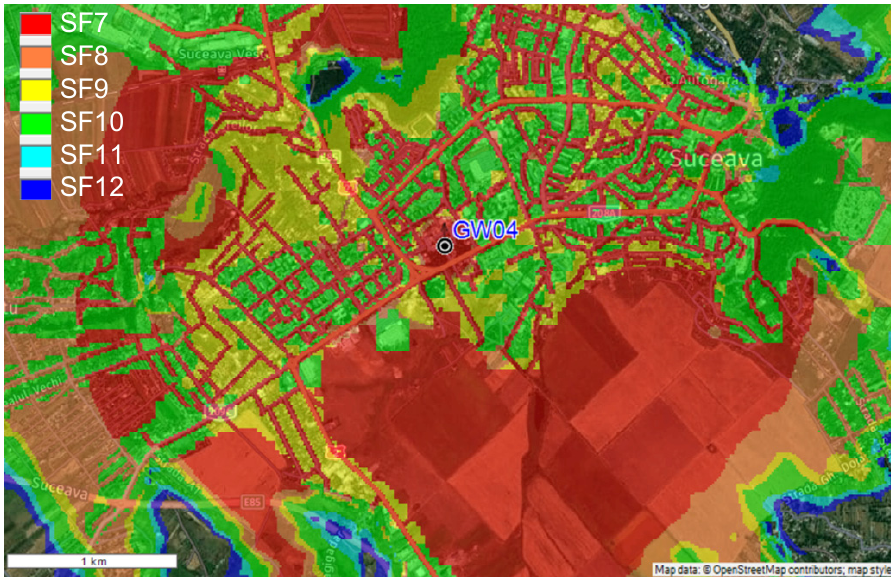
Figure 7. Field coverage measurements—single GW configuration.